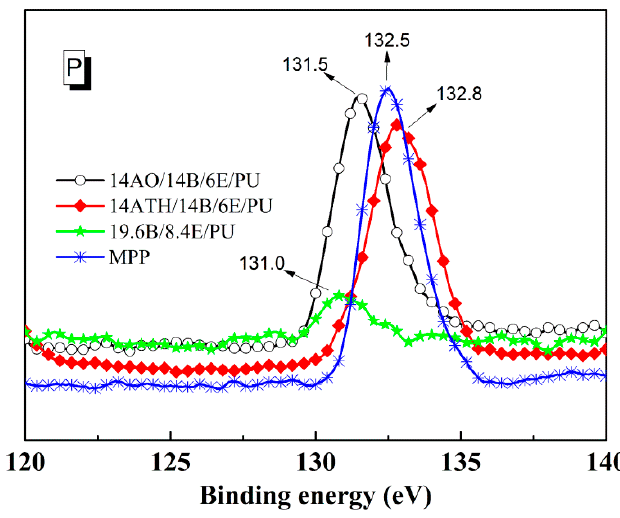
Figure 5. Energy spectra of phosphorus in residues and melamine polyphosphate (MPP).